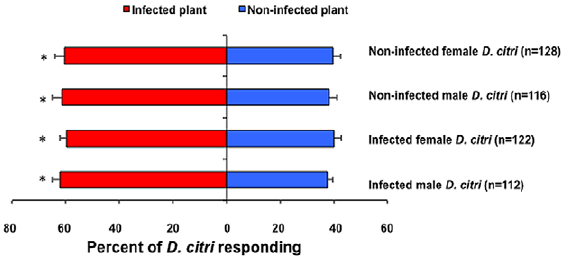
Figure 1. Response of D. citri to odors emitted from Las- infected versus non-infected citrus in a laboratory olfactome- ter. Bars labeled by an asterisk are significantly different ( x 2 test, p , 0.05). n=total number of psyllids that